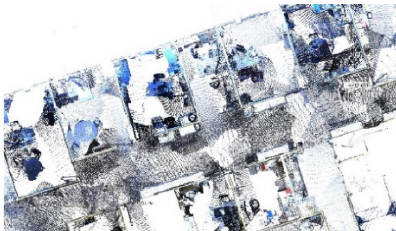
Figure 10. The atypical corridor which has salient rooms and hollow partitions is recovered only partially successfully.